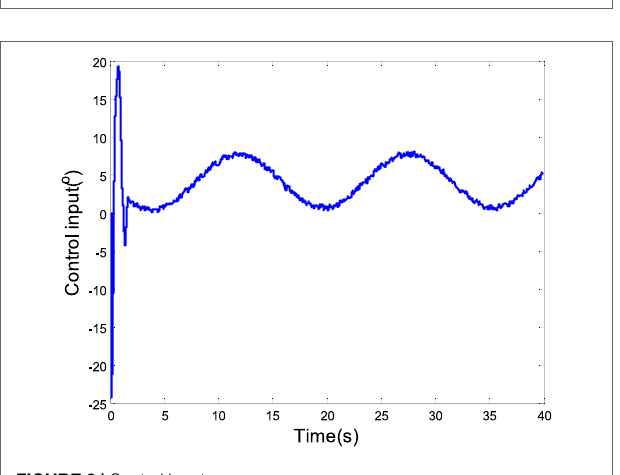
FIGURE 4 | Angular velocity.